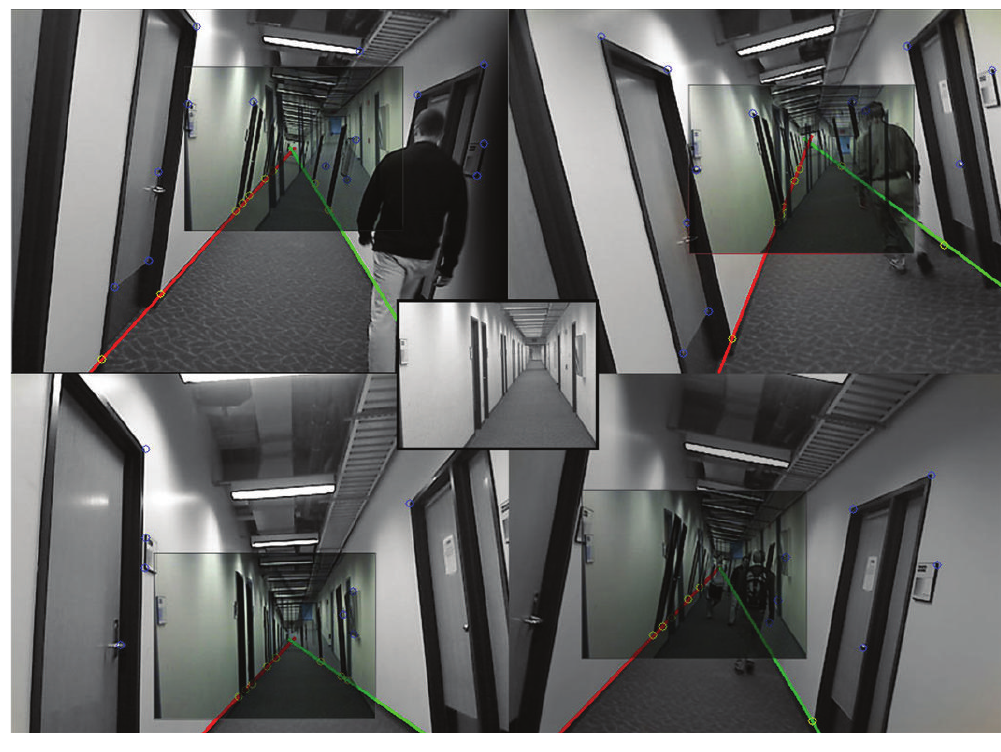
Figure 10: Data association metric where a descriptor is shown on the middle.